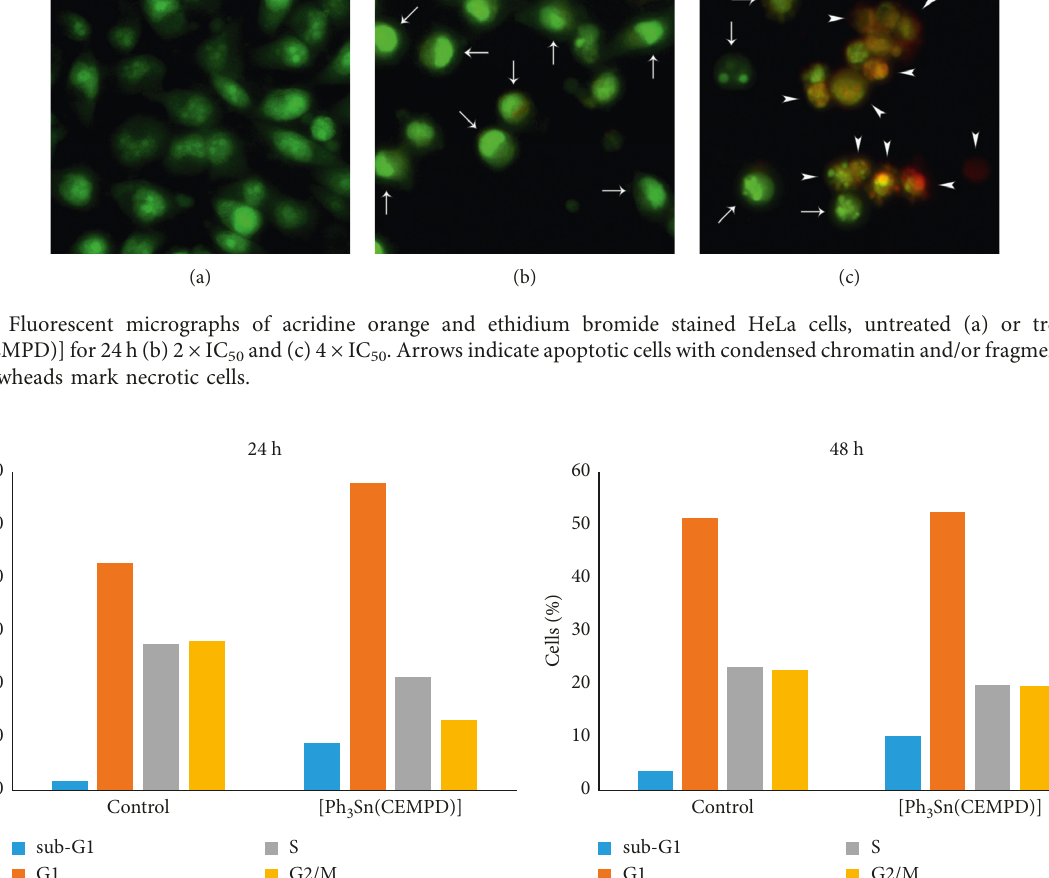
3 Sn(CEMPD)] on cell cycle phase distribution: HeLa cell lines were exposed to IC 50 doses of organotin(IV)